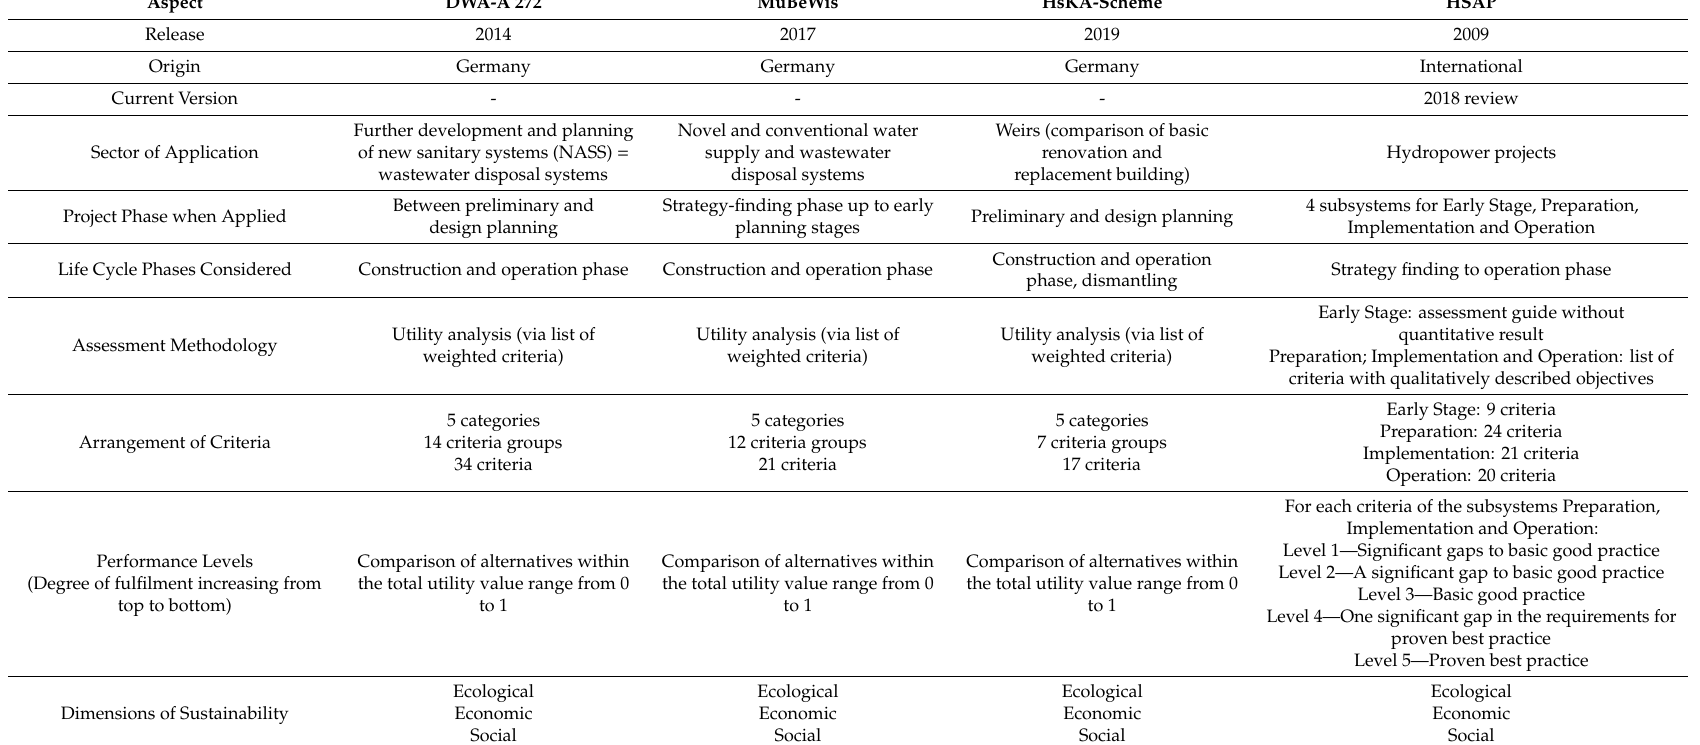
Table 4. Assessment schemes specialized in water infrastructure (based on data from: [35,42–46]).